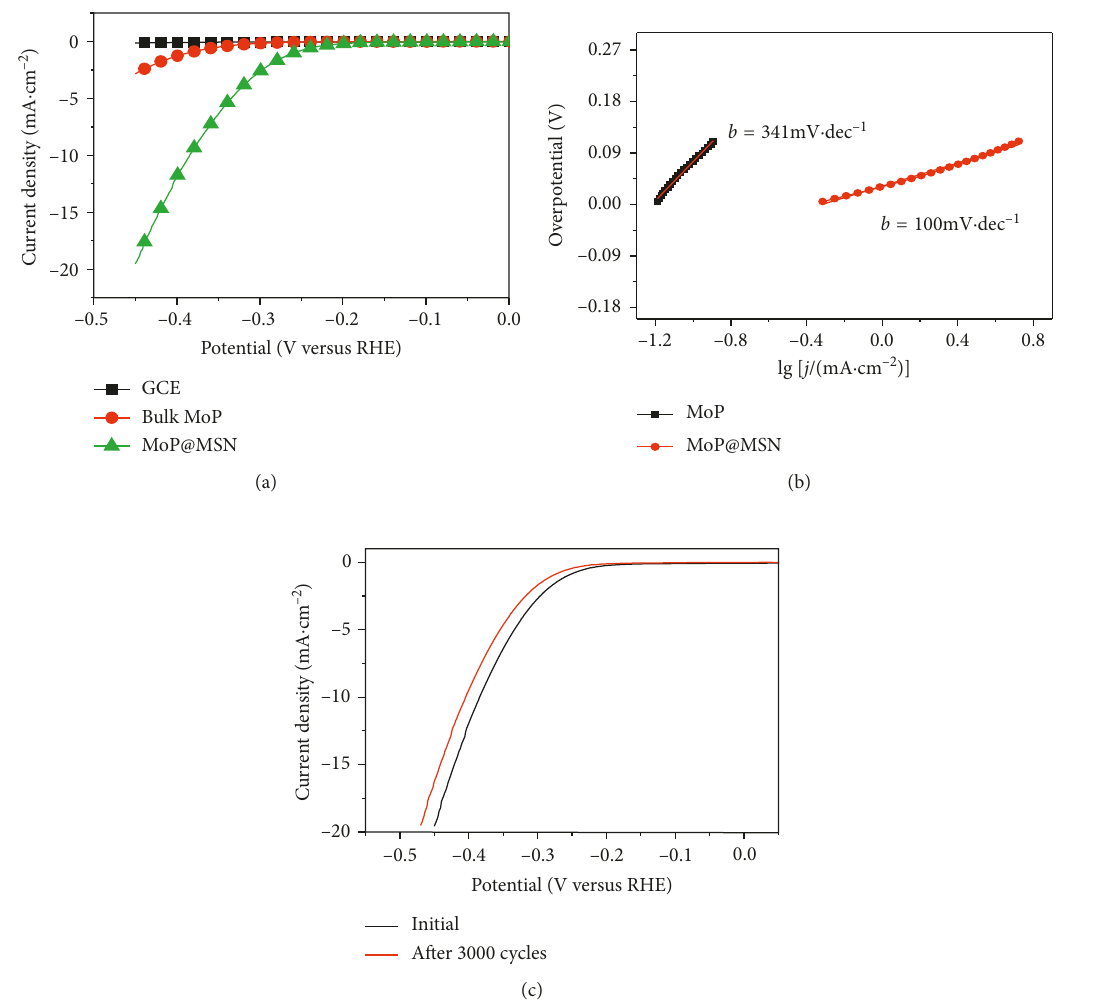
Figure 3: (a) TEM of MoP@MSN and (b) HRTEM of MoP@MSN.